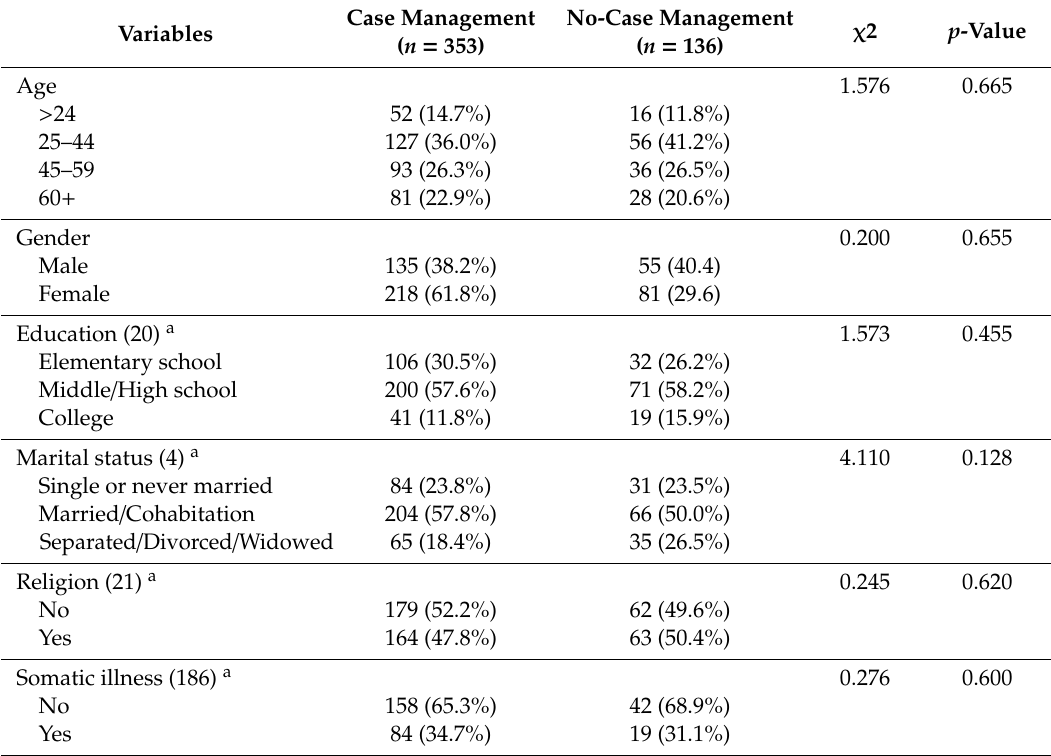
Table 1. Demographic characteristics of the